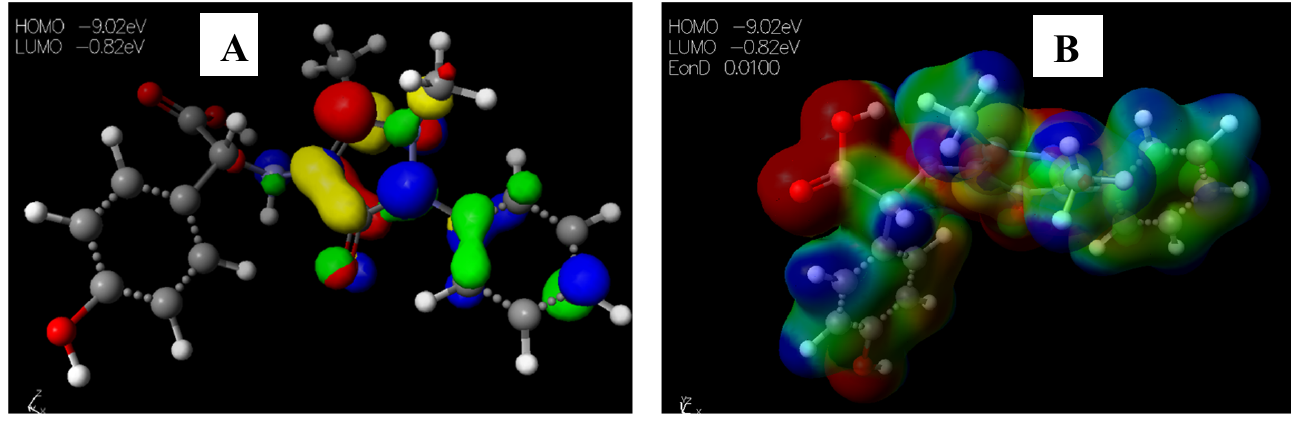
Figure 8. Images showing the ( A ) Highest occupied molecular orbital (HOMO) and Lowest unoc- cupied molecular orbital (LUMO) and ( B ) Molecular electrostatic potential (MESP) plots of 4.